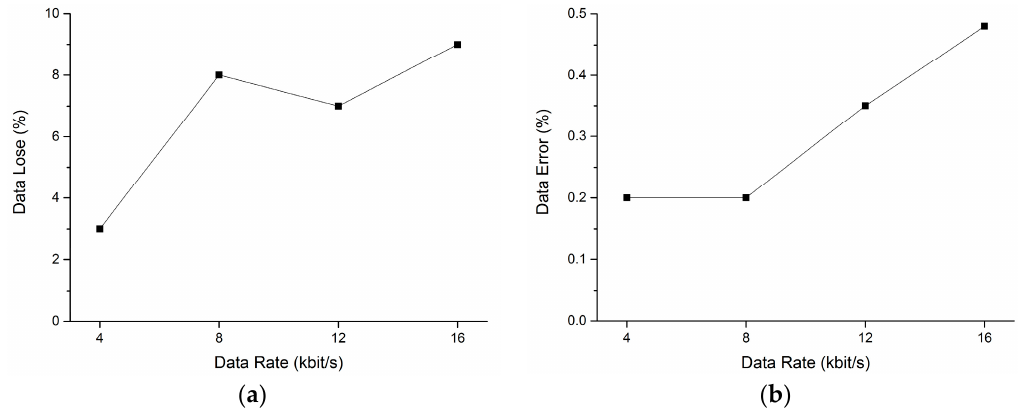
Figure 15. ( a ) Percentage of data loss and ( b ) bit error rate with respect to data rate.